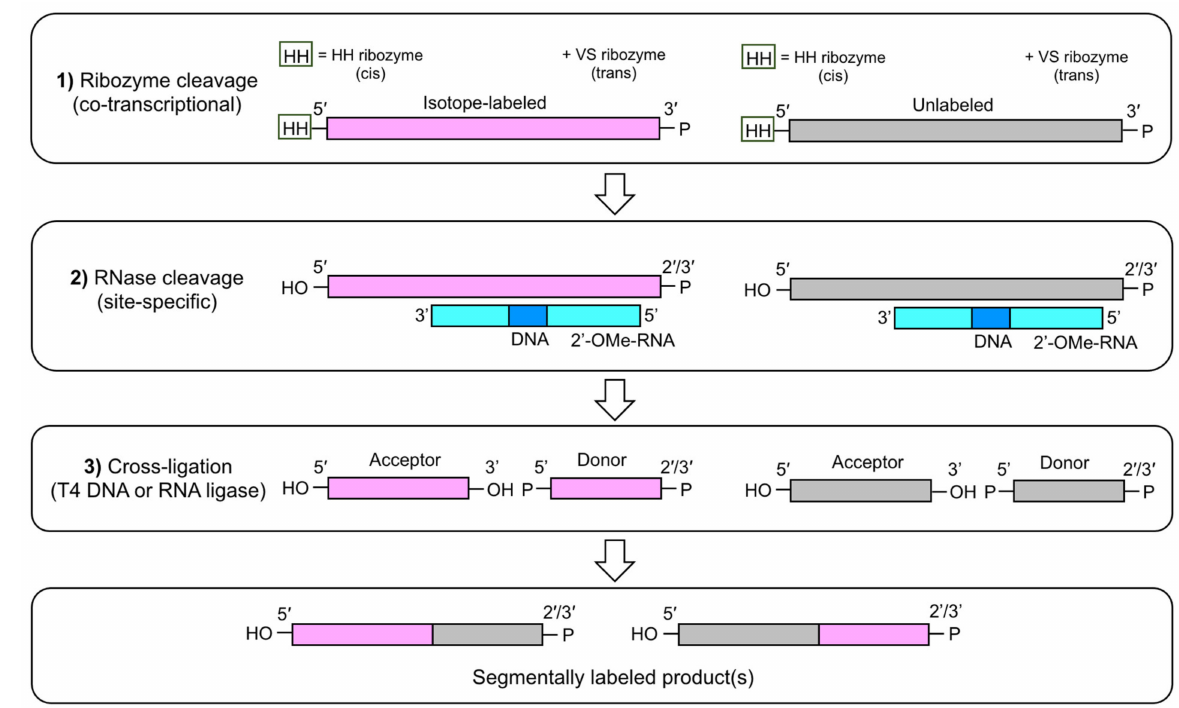
Figure 6. Segmental RNA labeling strategy adapted from Allain and co-workers [107]. Labeling is achieved via IVT of identical unlabeled and isotope-labeled and fragments along with HH (cis) and VS (trans) ribozymes which are cleaved co-transcriptionally (step 1). Then, site-specific RNase H cleavage is facilitated by a DNA/RNA chimera (step 2) following cross ligation reactions with T4 DNA or RNA ligases to yield segmentally labeled RNA (step 3). Additional details can be found in the original work